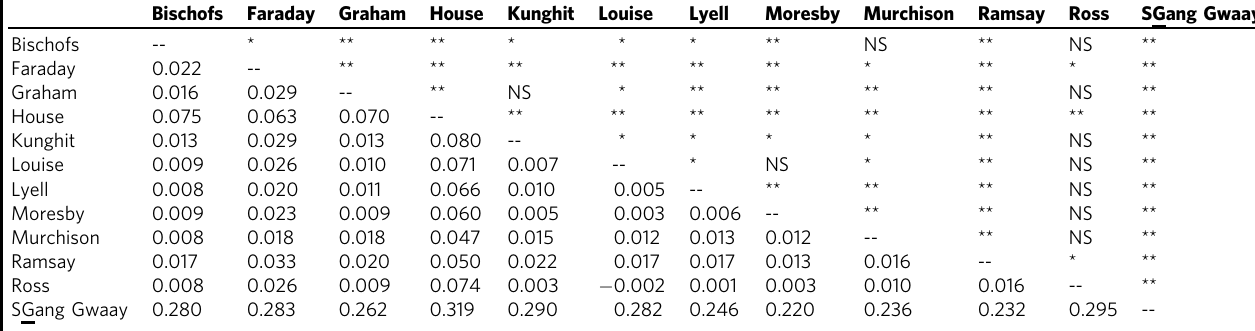
Table 2 Pairwise genetic differentiation for Sitka black-tailed deer between islands, shown below the diagonal. Bischofs Faraday Graham House Kunghit Louise